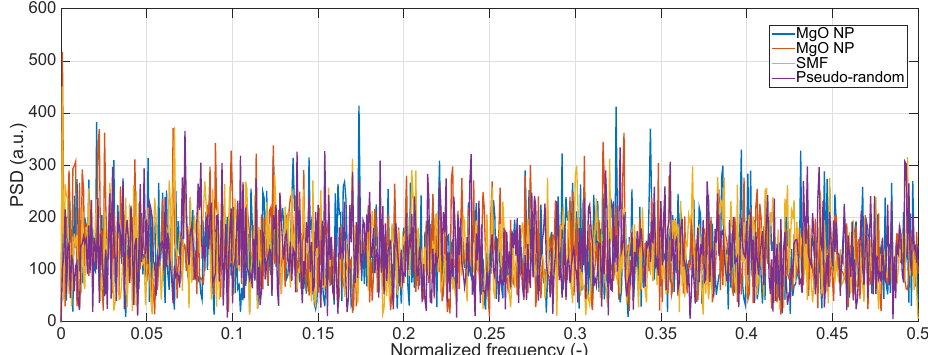
Figure A3. Power spectral density (PSD) or 2 MgO-NP and one SMF signatures, compared with a pseudo-random Gaussian process.